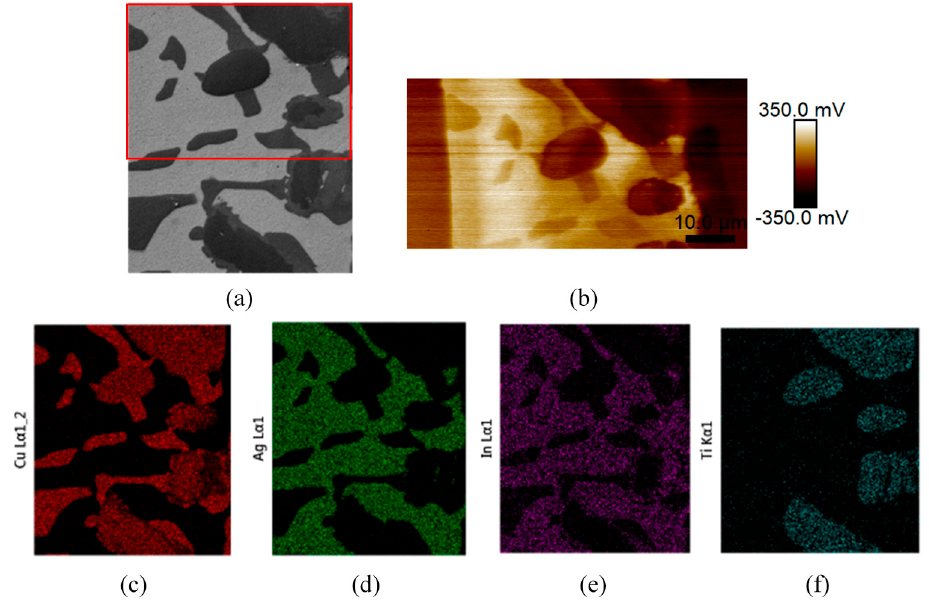
Figure 8. Secondary electron SEM image of Cu ‐ Ag ‐ Ti sample ( a ) followed by corresponding Scanning Kelvin Probe Force Microscopy (SKPFM) surface potential image ( b ). EDS elemental maps of the identical region for: Titanium ( c ); Copper ( d ); and Silver ( e ) are shown.